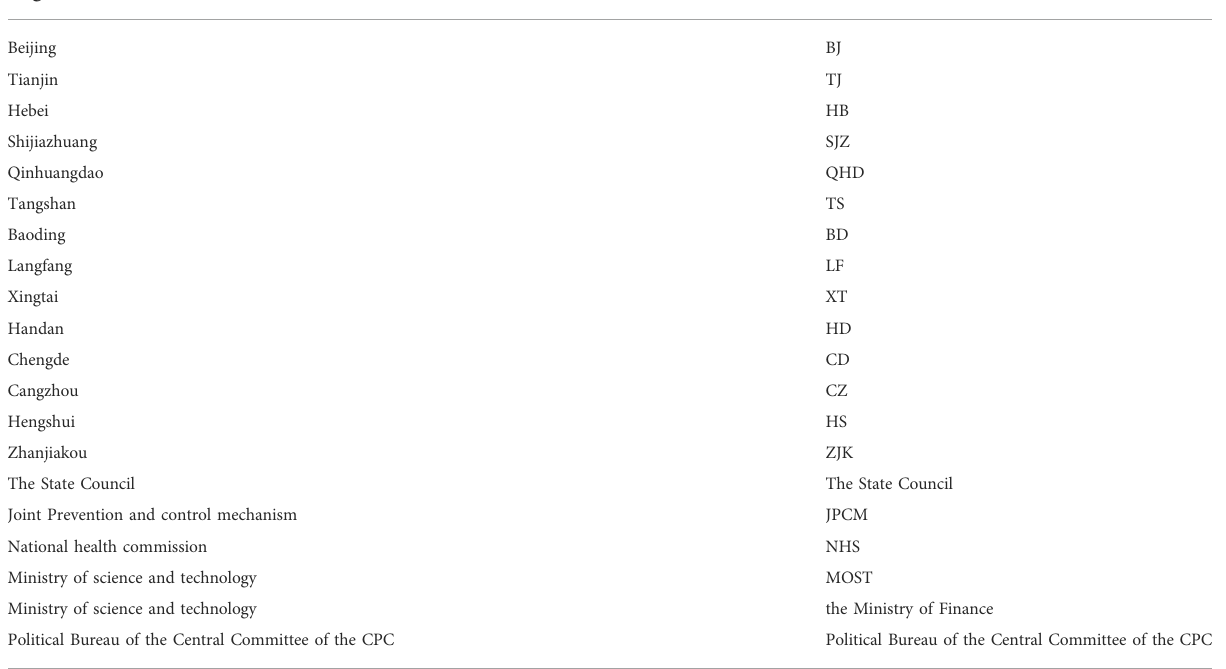
TABLE 1 Region and